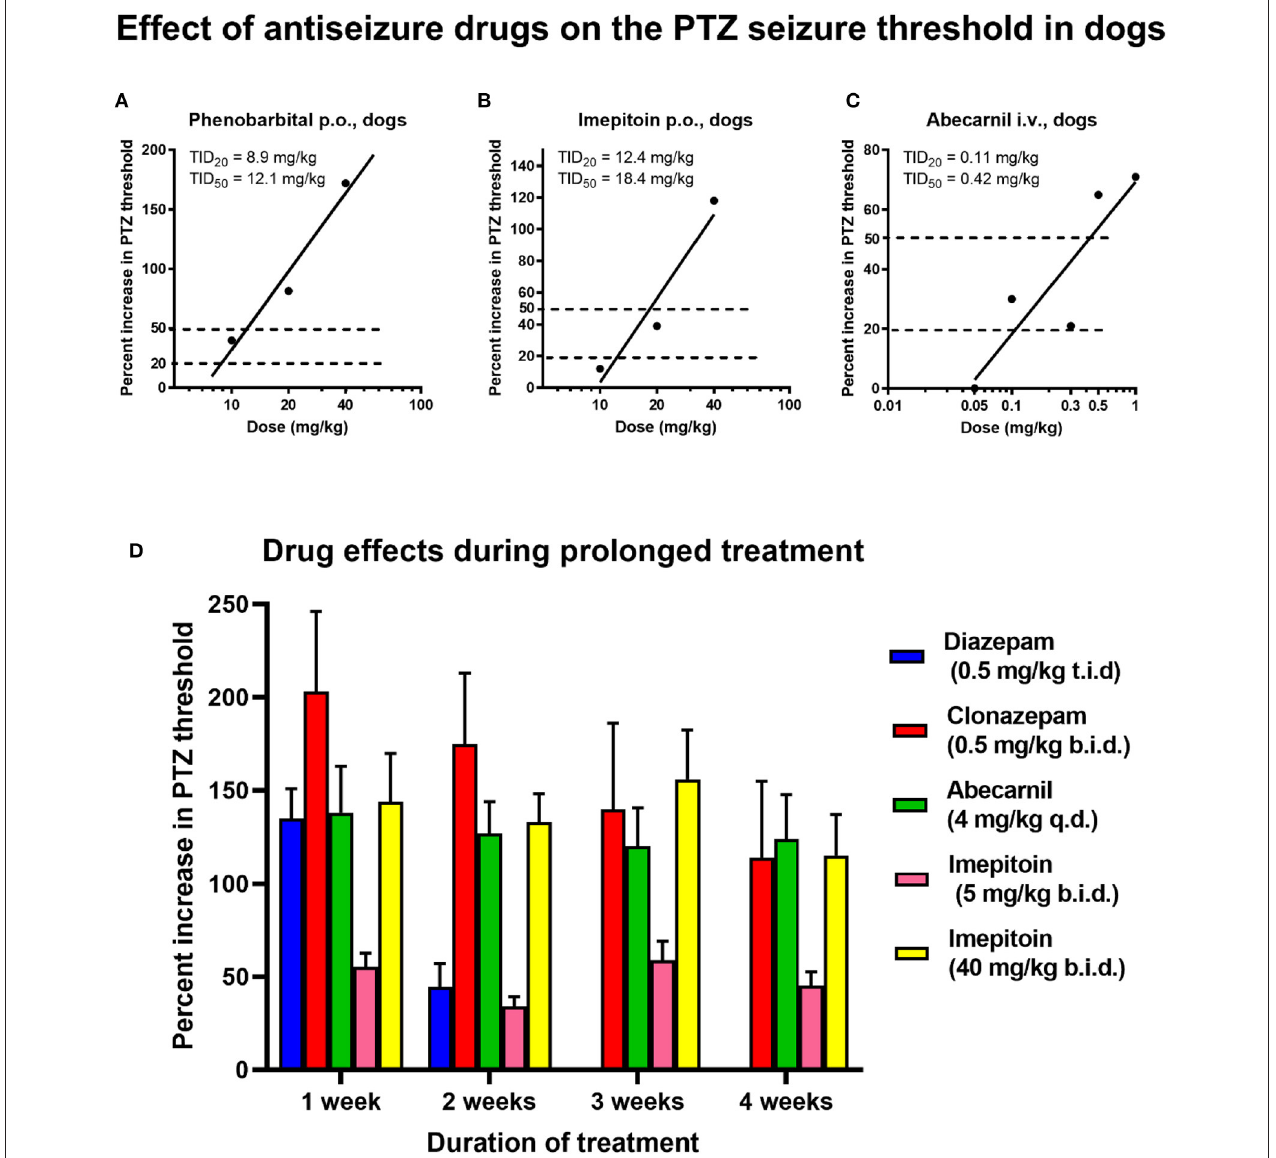
FIGURE 7 | Effect of antiseizure drugs on the timed i.v. pentylenetetrazol (PTZ) seizure threshold test in dogs. (A) Effect of different doses of phenobarbital on the PTZ seizure threshold, shown as percent increase above control threshold. Each symbol presents the percent increase in seizure threshold in a group of 6–7 dogs. By nonlinear regression analysis, the doses increasing the seizure threshold by 20% (TID 20 ) and 50% (TID 50 ) were calculated. (B) Effect of different doses of imepitoin on the PTZ seizure threshold. Other details as in (A) . (C) Effect of different doses of abecarnil on the PTZ seizure threshold. Other details as in (A) . (D) Alterations in antiseizure efficacy during prolonged treatment in dogs. Four drugs were compared in groups of 4–7 dogs: diazepam, clonazepam, abecarnil, and imepitoin. These drugs were administered daily over 4 weeks. The first PTZ seizure threshold was determined after 1 week of treatment. Control thresholds were repeatedly determined in each dog before the onset of treatment. Data are shown as the drug-induced mean percent increase ( ± SEM) above control thresholds. Note the rapid decline of antiseizure efficacy of diazepam, indicating the development of tolerance. Tolerance, although less marked, was also observed with clonazepam, but not with imepitoin or abecarnil. Data are from Frey et al. (271), Scherkl et al. (272), Löscher et al. (273), and Löscher et al. (171,